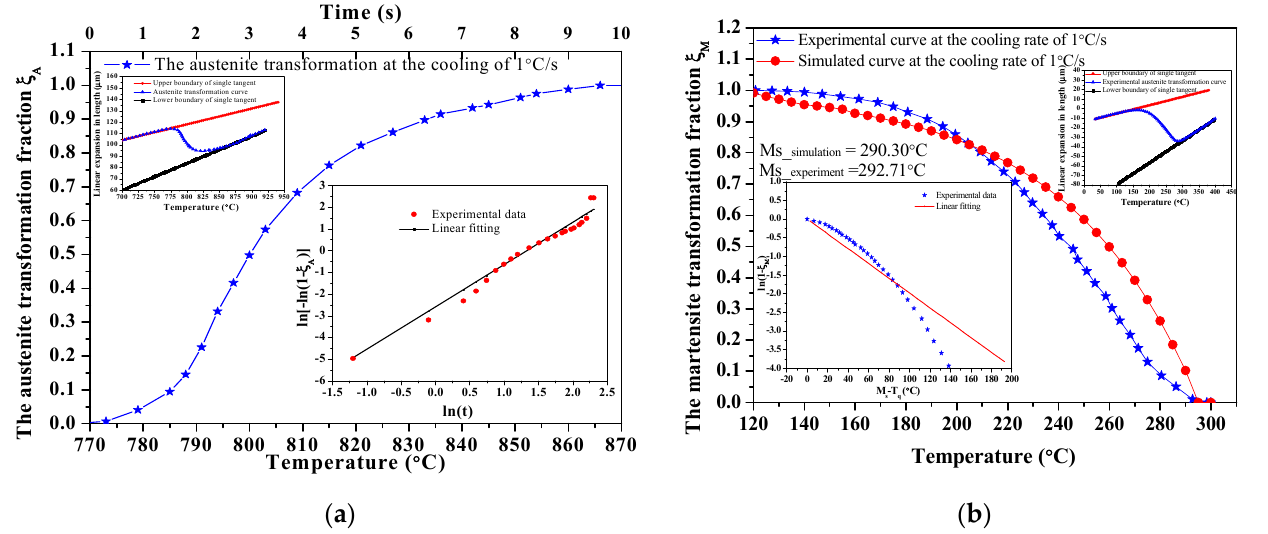
Figure 5. Phase transformation fraction in cooling at 1.0 °C/s: ( a ) austenite transformation; ( b ) martensite transformation.